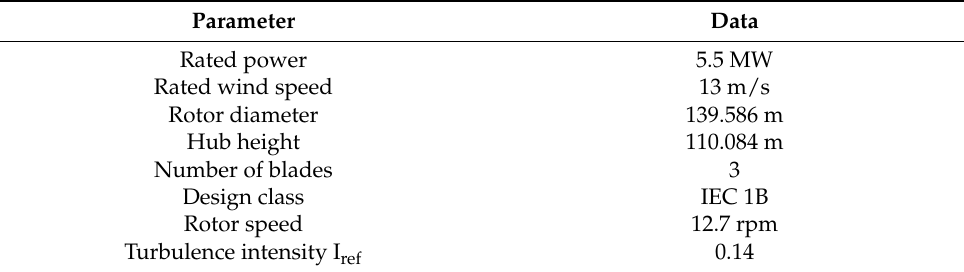
Figure 13. Time history of wind thrust. Table 6. Basic design parameter of 5.5MW capacity OWTs.